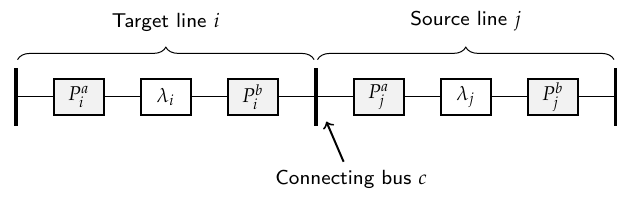
Figure 2. Two adjacent transmission lines, i and j